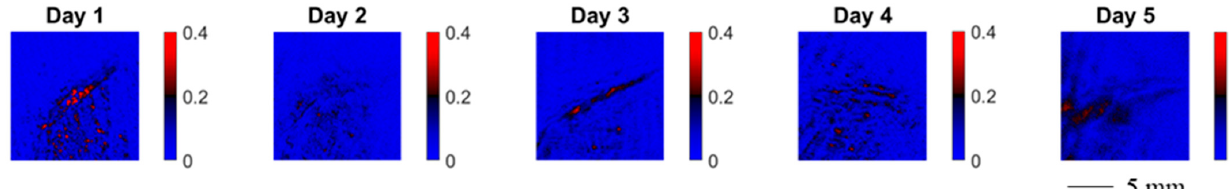
Figure 9. Spatially resolved diattenuation 𝐷 for wound healing monitoring of a cut in a finger. The wound was measured five consecutive days after the cut. Between measurements, the wound’s orientation changes in the image.